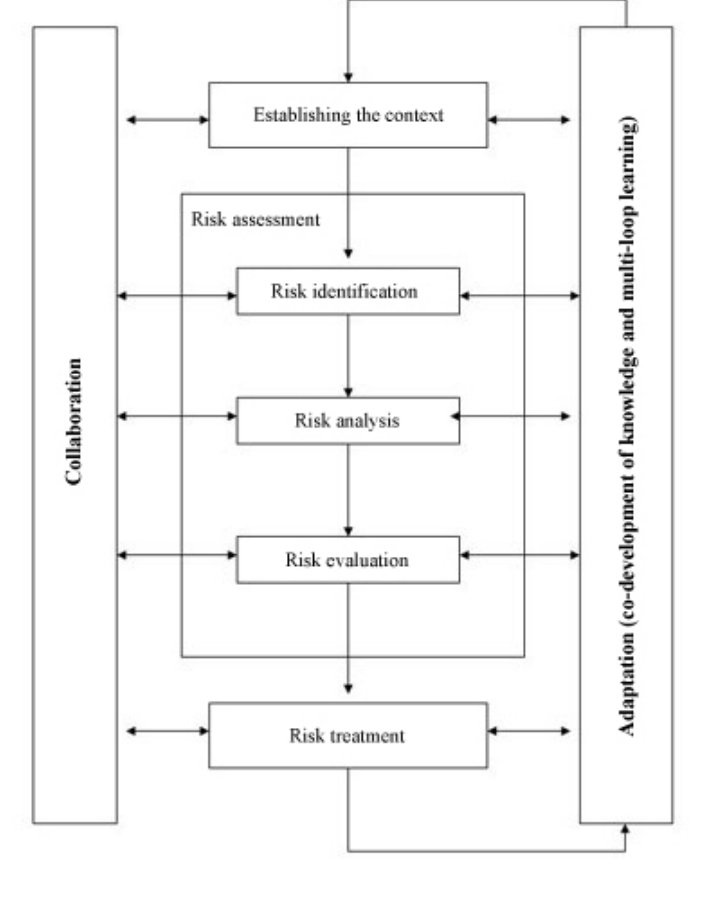
Fig. 1 . Adaptive collaborative risk management (adapted from CAN/CSA-ISO 31000